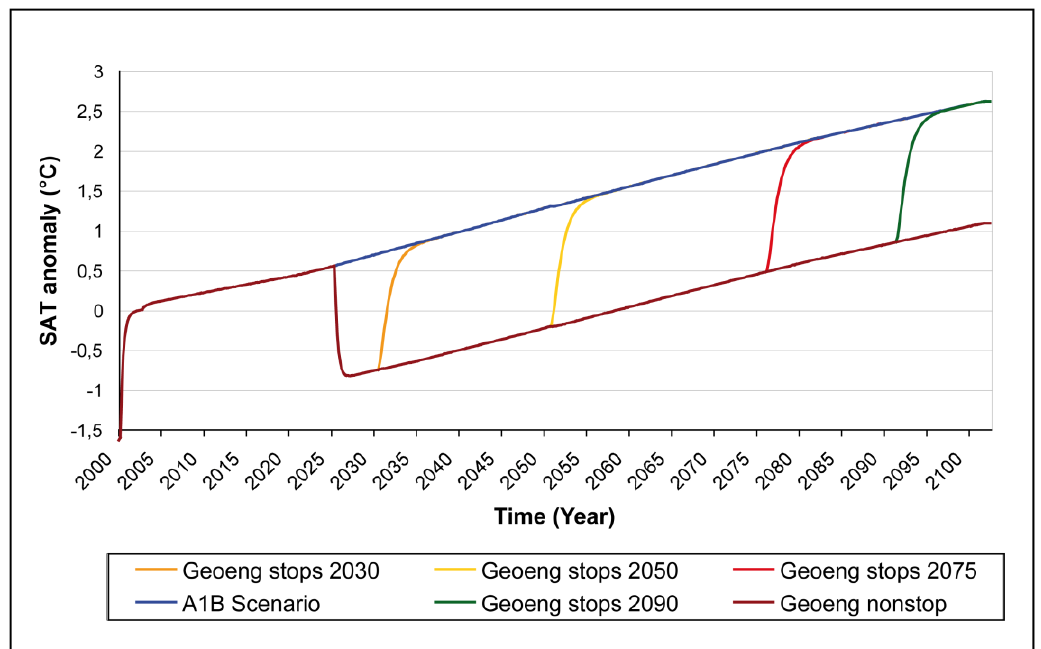
Figure 3. SAT response to geoengineering failures at different times with a constant loading equivalent to Mount Pinatubo‘s